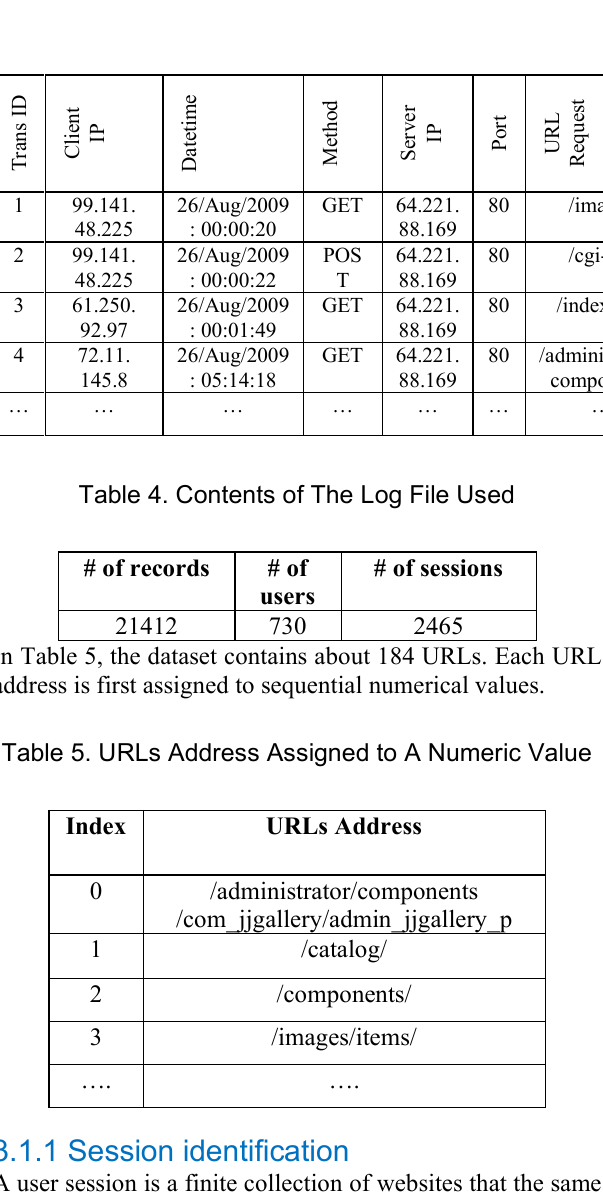
Table 3. Preprocessed Log File